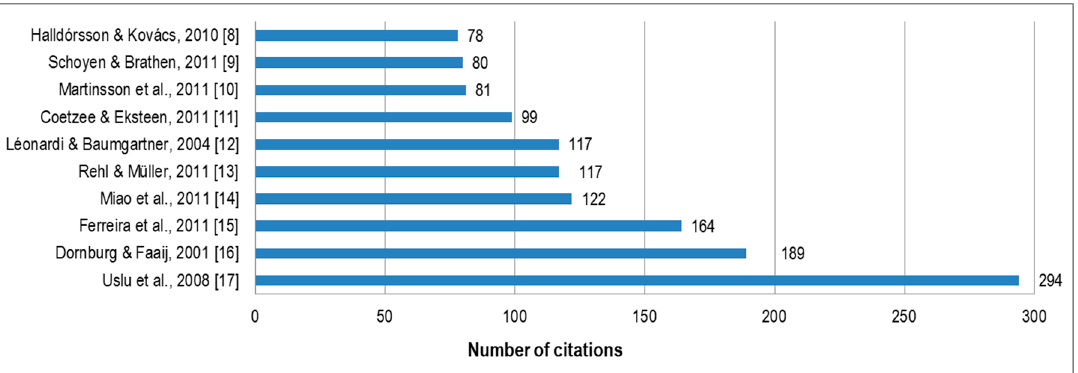
Figure 4. The 10 most cited articles based on search in Scopus database.